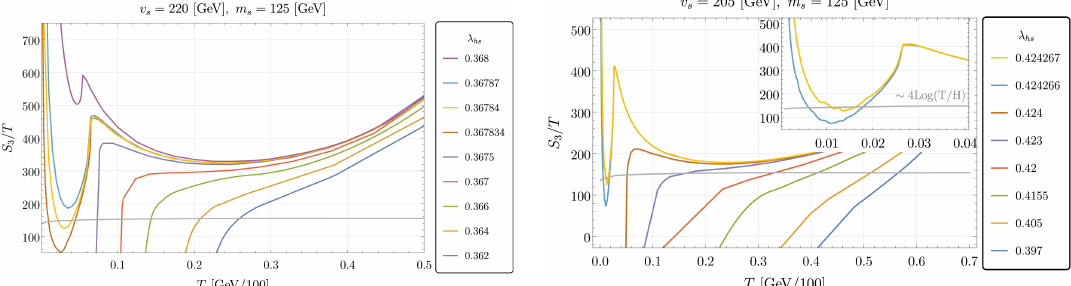
Figure 4 . Left : plot of S 3 ( T ) /T as a function of the temperature, for different values of λ hs in the case where m s = 125 GeV and v s = 220 GeV. As we increase the value of the coupling λ hs , the disappearance of the potential barrier happens later, allowing for longer supercooling, until it is large enough to remain even at zero temperature. For the first four curves from the top, we observe a second drop in the function at very low temperature. This second drop corresponds to the displacement on the false minimum that we describe in this section. Right : same plot as in the left panel, but with a lower value for v s . The pattern we found is the same, but lowering v s causes a lowering of the curves and the displacement of the false minimum is less pronounced.